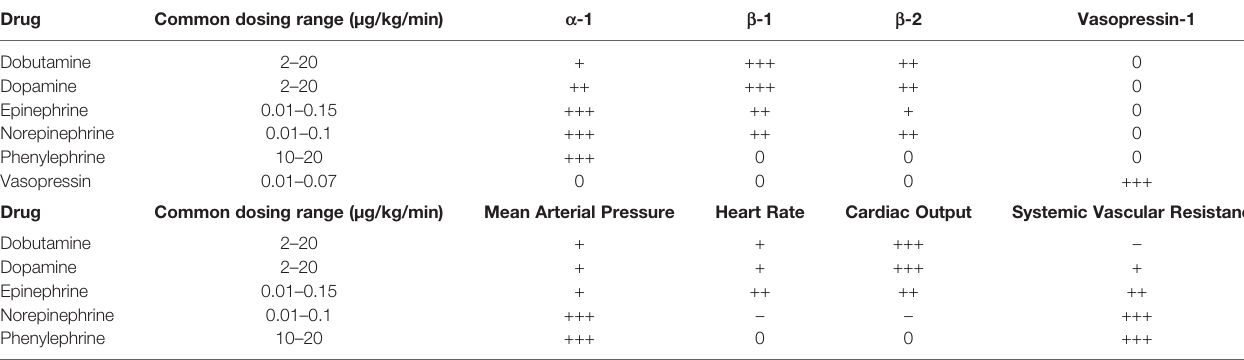
TABLE 3 | Physiologic Effects of Common